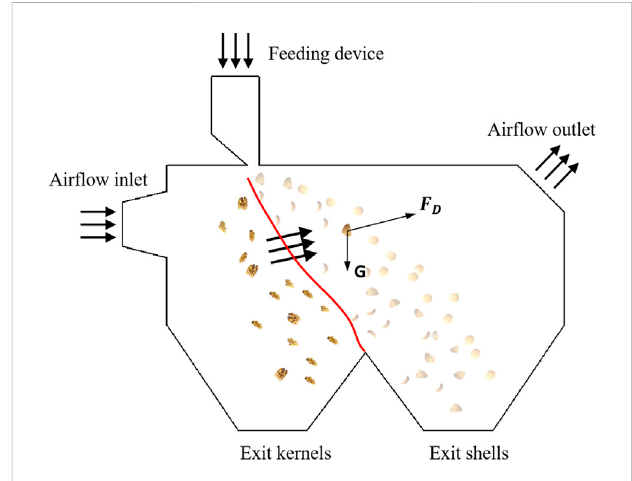
FIGURE 1 Demonstration diagram of the separation